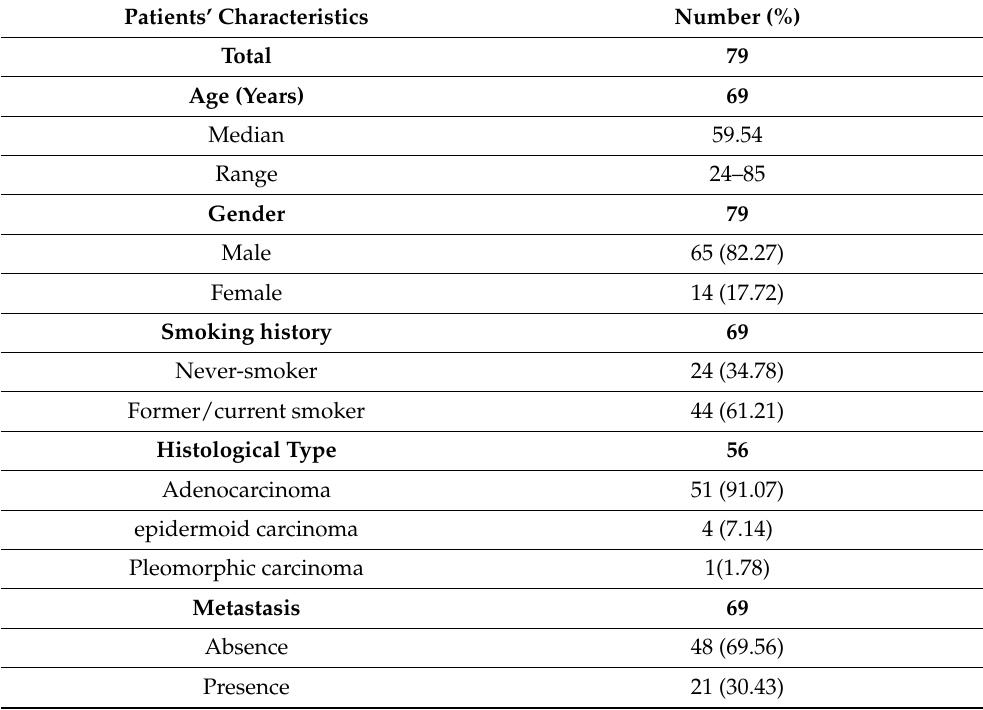
Table 1. Clinical pathological characteristics of